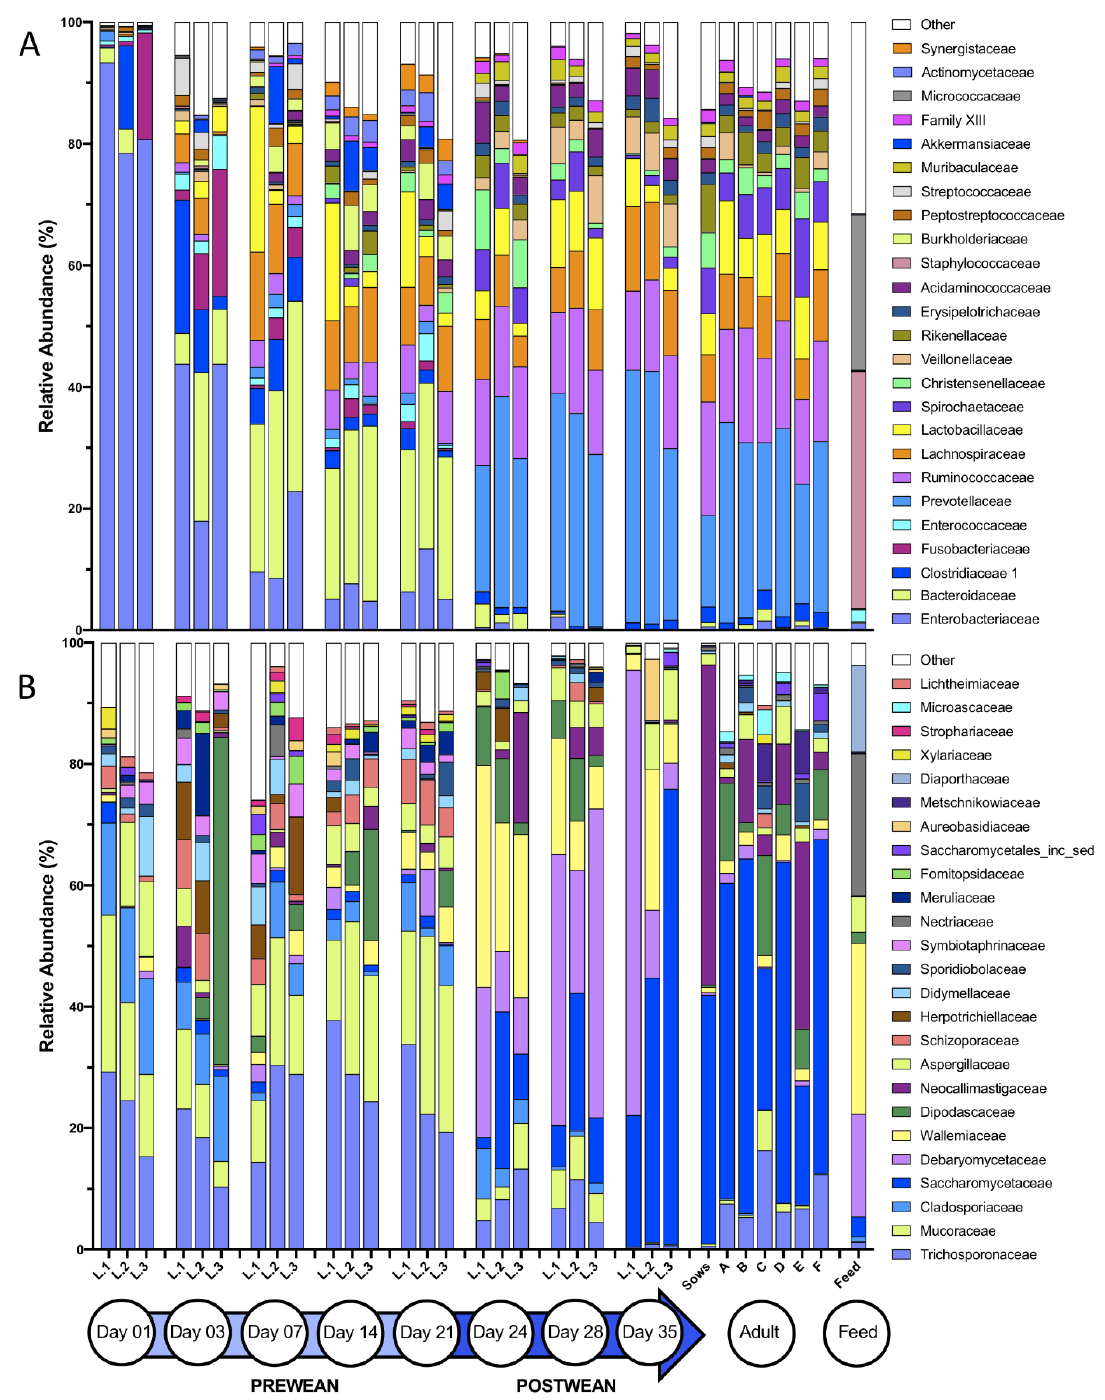
Figure 4. Taxonomic composition of the bacteriome and mycobiome in piglet feces over time. Mean percent relative abundances by litter (L.1–3) at the family level for the most abundant members of the ( A ) bacteriome and ( B ) mycobiome over time (D01–35). Sows (Sows), adult feces (A–F), and nursery feed (Feed) are included for comparison.